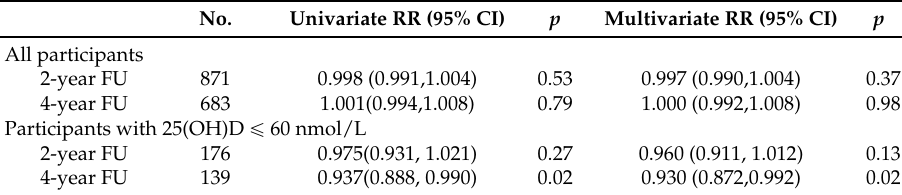
Table 4. Risk ratio (RR) and 95% CI confidence interval for moderate/severe Lower Urinary Tract Symptoms (LUTS) at two-year and four-year follow-ups according to the baseline serum 25(OH)D